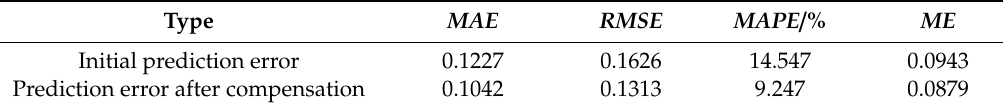
Table 5. Comparison of prediction error before and after compensation of PV.